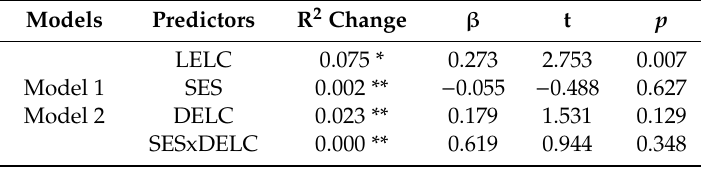
Table 9. Results of the hierarchical regression analyses on inhibition (day and night). R 2 = 0.10.